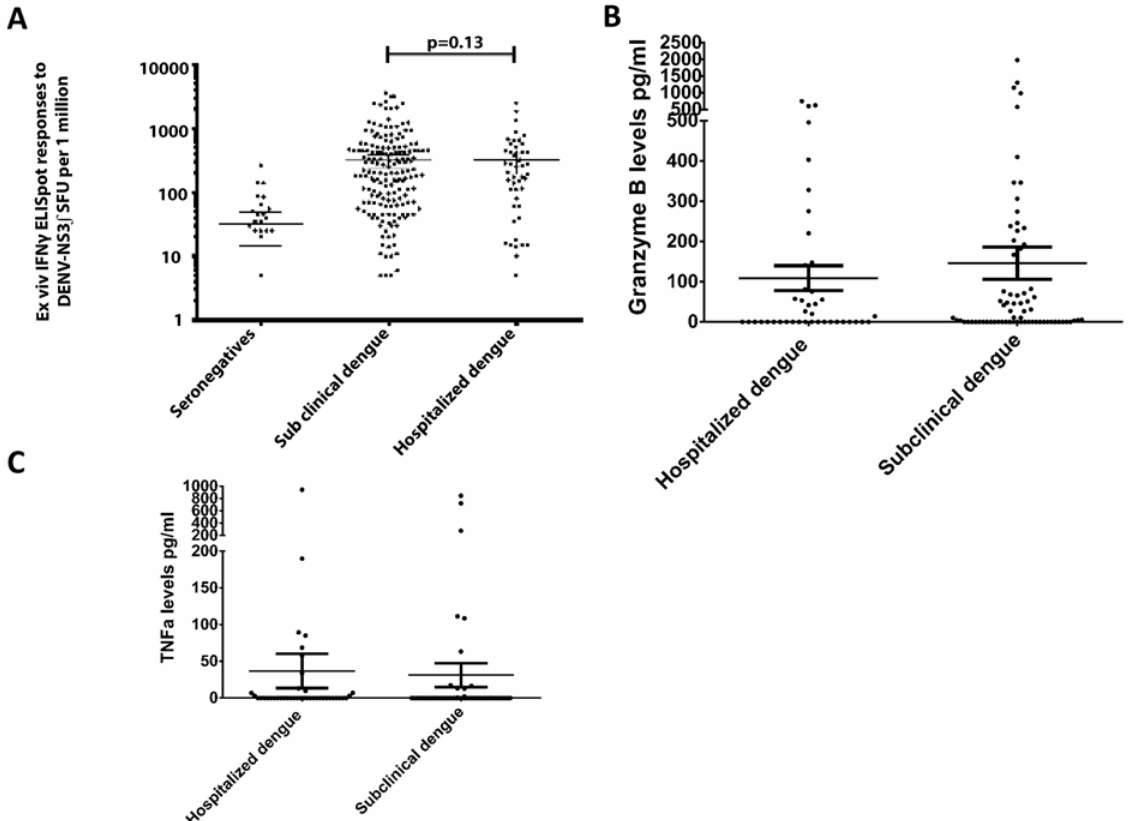
Fig 1. Cross reactive dengue-specific immune responses and disease severity. A: Circulating NS3-specific IFN γ ex vivo ELISpot responses were measured in individuals who were hospitalized due to dengue and in those with past mild/sub clinical dengue infection. B: Granzyme B production by PBMCs from individuals who were hospitalized due to dengue and who had a past mild/sub clinical dengue infection, following stimulation with DENV-NS3 overlapping peptides. C: TNF α production by PBMCs from individuals who were hospitalized due to dengue and those with past mild/sub clinical dengue infection following stimulation with DENV-NS3 overlapping